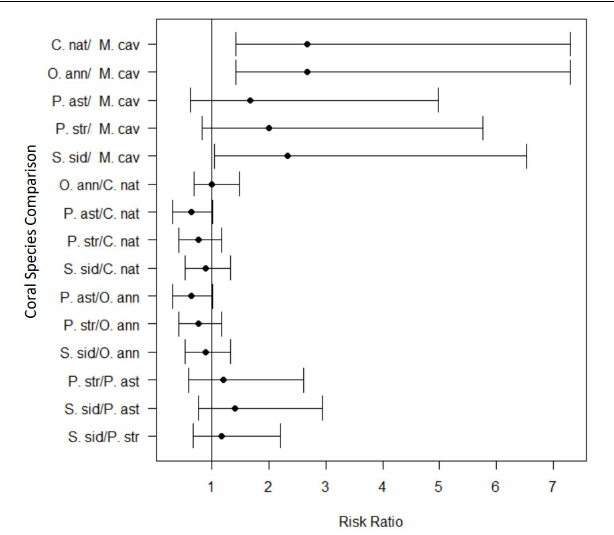
FIGURE 6 | Pairwise comparisons of the risk ratio for each coral species exposed to stony coral tissue loss disease within the transmission experiment. The black circles represent the mean risk ratio and the brackets represent the 95% confidence interval. The vertical black line identifies the risk value of one. When the 95% confidence interval spans this line, there is no significant difference in the risk of lesion development between the two species tested. Values completely above the line indicate a significantly higher risk of lesion development for the first species listed in the pairwise comparison. Values completely below the line indicate a lower risk of lesion development for the first species listed in the pairwise